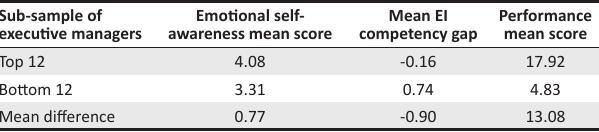
TABLE 6: Mean differences between the top and bottom 12 Emotional and Social Competence Inventory emotional self-awareness score, emotional intelligence competency gap and performance